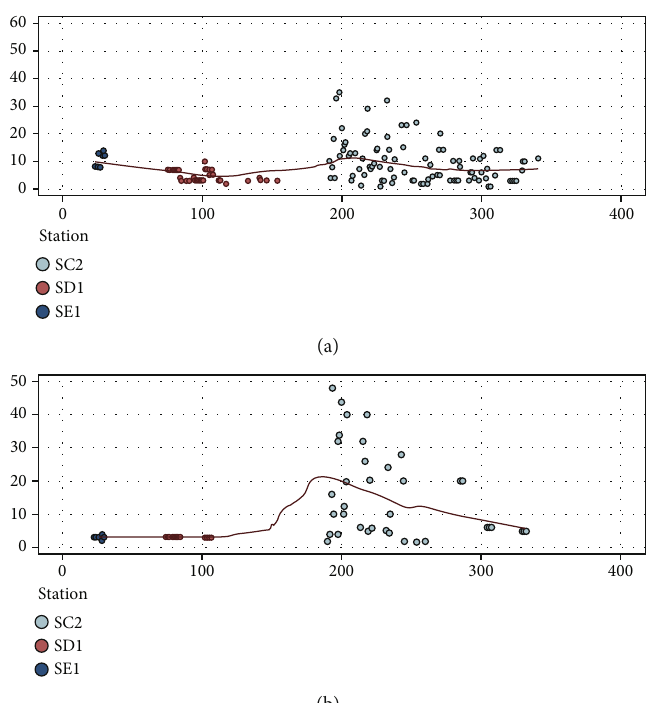
Figure 7: Analog signal analysis (simulated data) used in di ff erent ground veri fi cation test orders for this project. Number of signals ( y -axis) vs. test order ( x -axis): (a) inputs and (b) outputs.